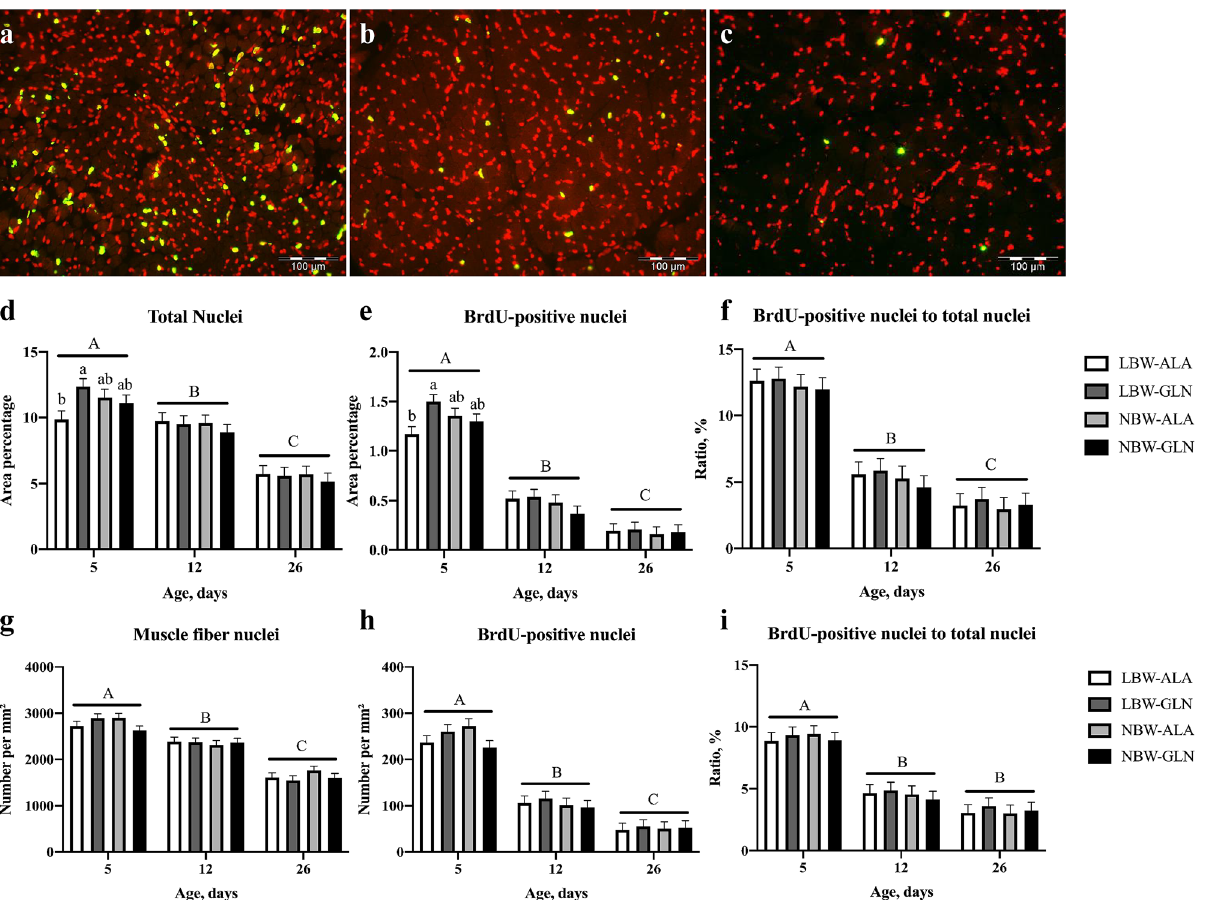
Figure 2. Detection and quantification of proliferating cells in M. longissimus . ( a – c ) Immunohistochemical detection of BrdU-positive nuclei (green) and total nuclei (red) at 5, 12 and 26 dpn; ( d ) area percentage of total nuclei; ( e ) area percentage of BrdU-positive nuclei; ( f ) ratio of BrdU-positive nuclei to total nuclei; ( g ) number of total nuclei per mm 2 in a region comprising muscle fibers exclusively; ( h ) number of BrdU-positive nuclei per mm 2 ; ( i ) ratio of BrdU-positive nuclei to total nuclei in M. longissimus of glutamine (GLN) or alanine (ALA) supplemented low birth weight (LBW) and normal birth weight (NBW) piglets at 5, 12 and 26 dpn. Values are presented as LSmeans and SE (n = 12 per group). Different uppercase letters (A-C) indicate significant differences among ages and different lowercase letters (a, b) indicate significant differences among groups within the same age ( p ≤ 0.05, Tukey–Kramer